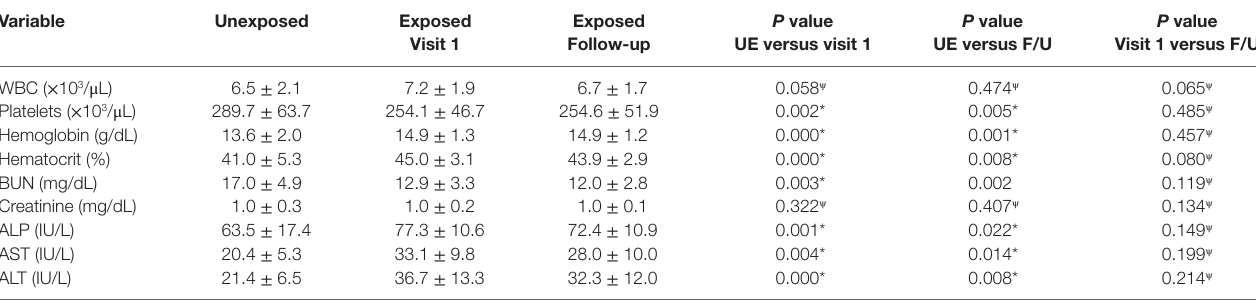
TaBle 1 | Comparison of hematologic and hepatic indices between the unexposed and exposed subjects to oil spill (44 each group). Variable Unexposed exposed Visit